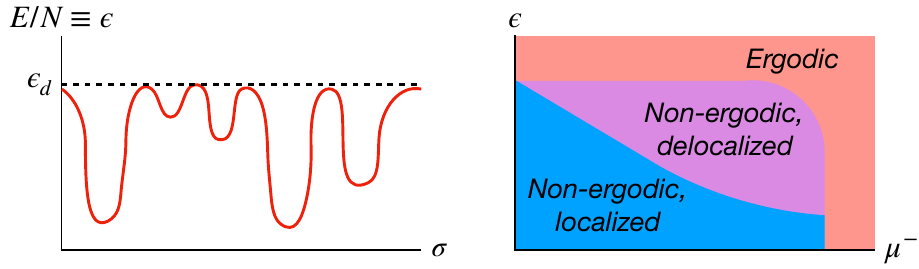
Figure 3 . (Left) Cartoon of the energy landscape in a 1RSB spin glass. The y-axis is energy per spin, E/N , where E is energy and N is the number of spins. Different points on the x-axis represent (very roughly, since the actual configuration space is N -dimensional) different spin configurations σ . The dashed line indicates the energy density (cid:15) d below which the system is non-ergodic. (Right) Sketch of the dynamical phase diagram for a quantum 1RSB spin glass. The x-axis represents parameters controlling the strength of quantum fluctuations, and the y-axis is energy density. Note that many other types of phase transitions are also present, in particular equilibrium transitions, but are not indicated here. See, e.g., refs. [26, 27, 40] for more